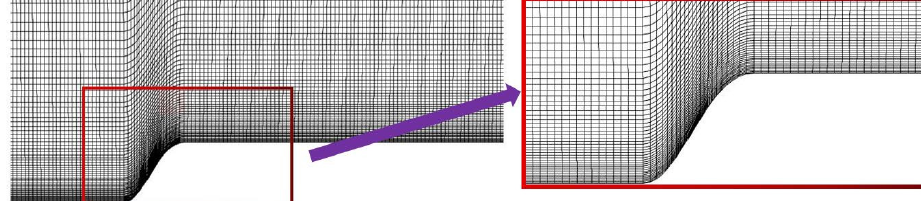
Figure 7. Mesh for the transition section. Figure 6. Computational domain and boundary conditions.